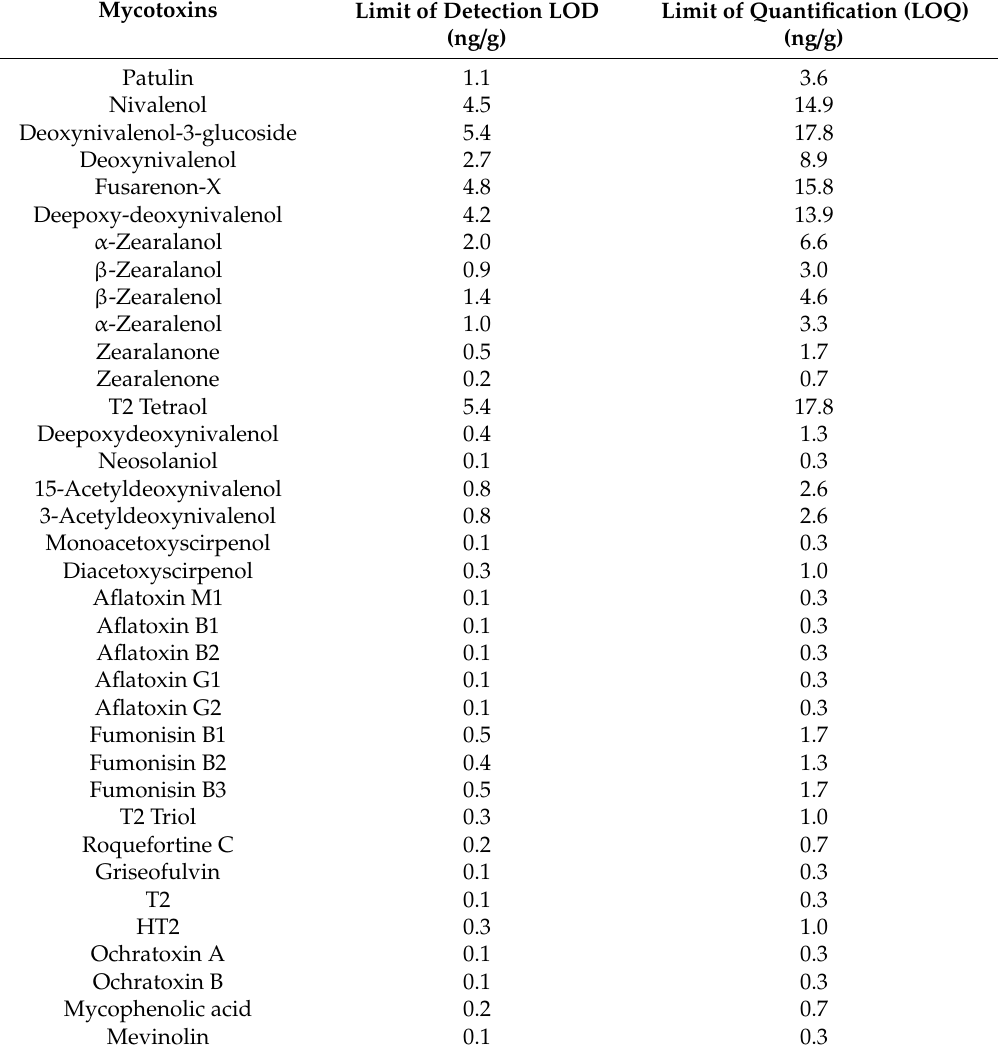
Table 3. Limits of detection (LOD) and Quantification (LOQ) for mycotoxins analysed by LC-MS /